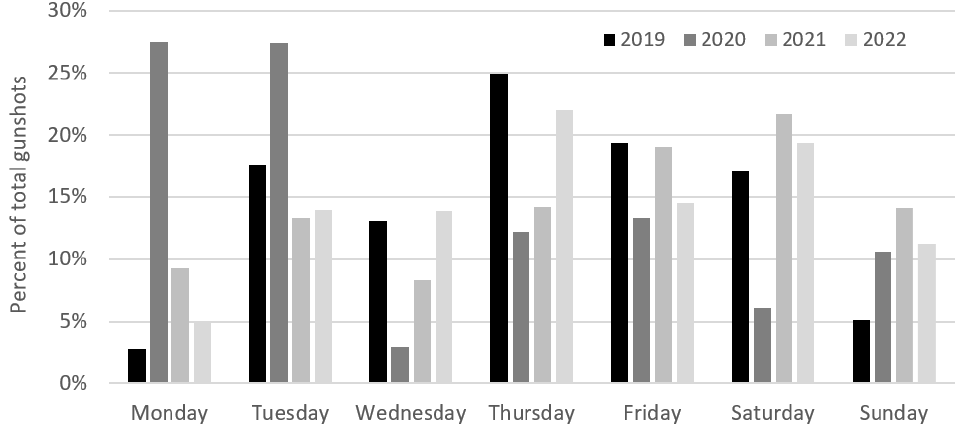
Figure 4. Weekly poaching pattern during the 2019–2022 spring migrations (n = 54,014).